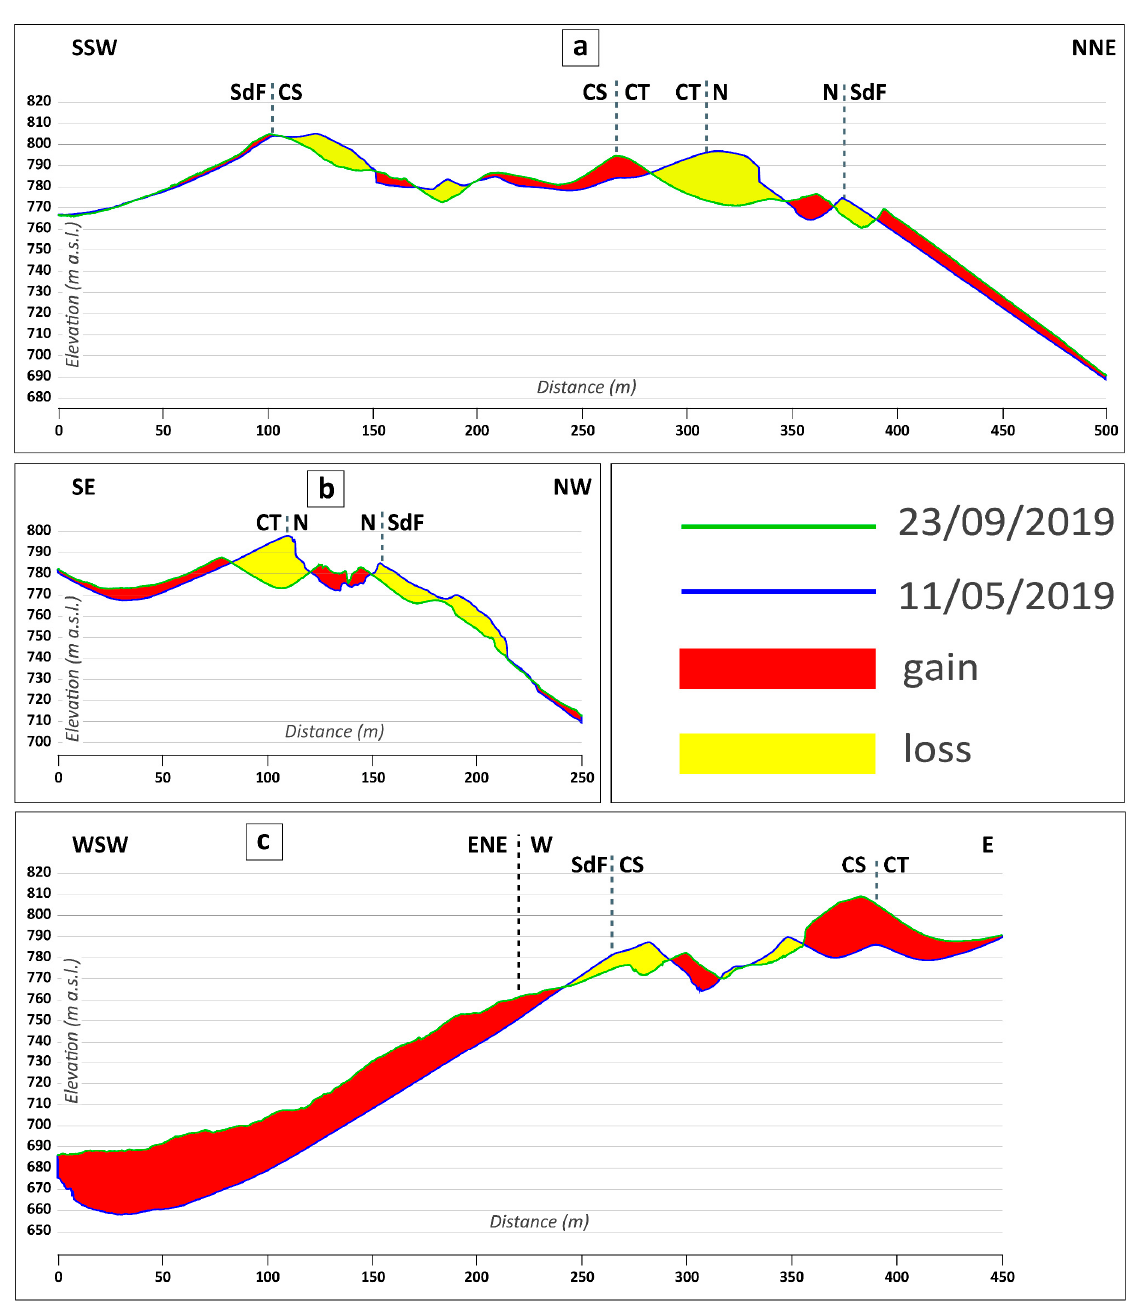
Figure 7. Comparison of cross-sections before and after the two paroxysmal events (topographic profiles of 11 May and 23 September 2019). ( a ) Cross-sections of the crater terrace along profile 1 in Figure 5. ( b ) Cross-sections of the SW crater area and upper SdF along profile 2 in Figure 5. ( c ) Cross-sections of the lava field and SW crater area along profile 3 in Figure 5.